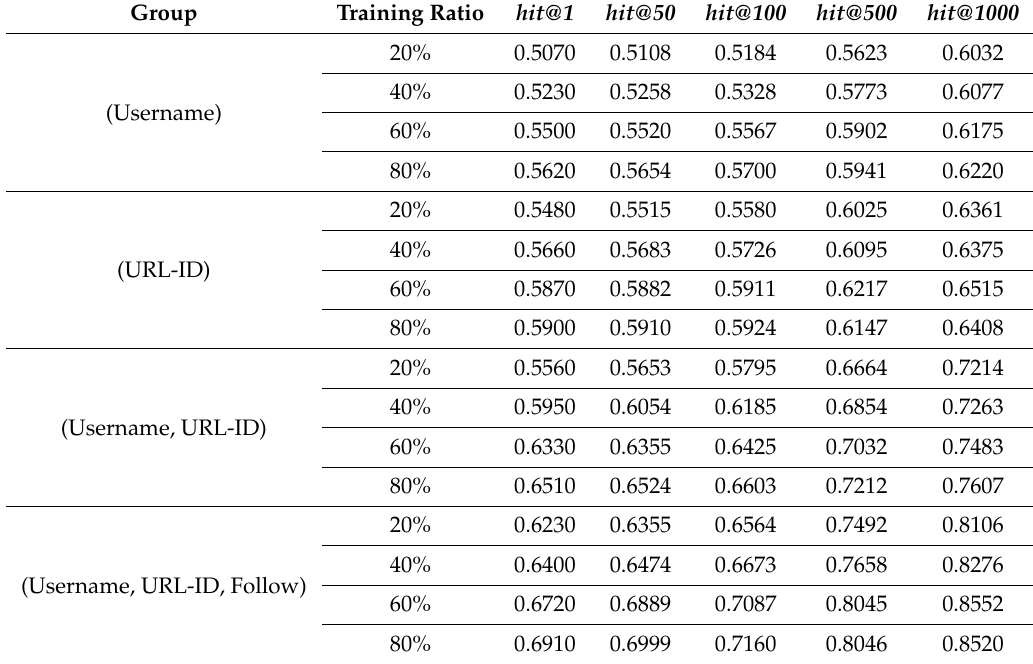
Table 1. Performance of different feature groups on the OSCHINA-Gitee dataset. Group Training